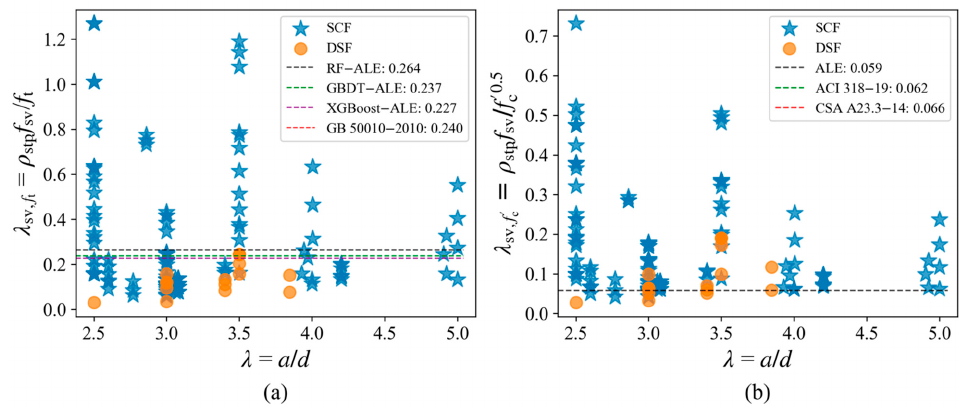
( a ) or λ sv, f (cid:48) ( b (a) or 𝜆 (b). Figure 10. The classification results are based on the minimum values of λ sv, f (cid:2929)(cid:2932),(cid:3033) (cid:3161)(cid:4594) t (cid:3178) c